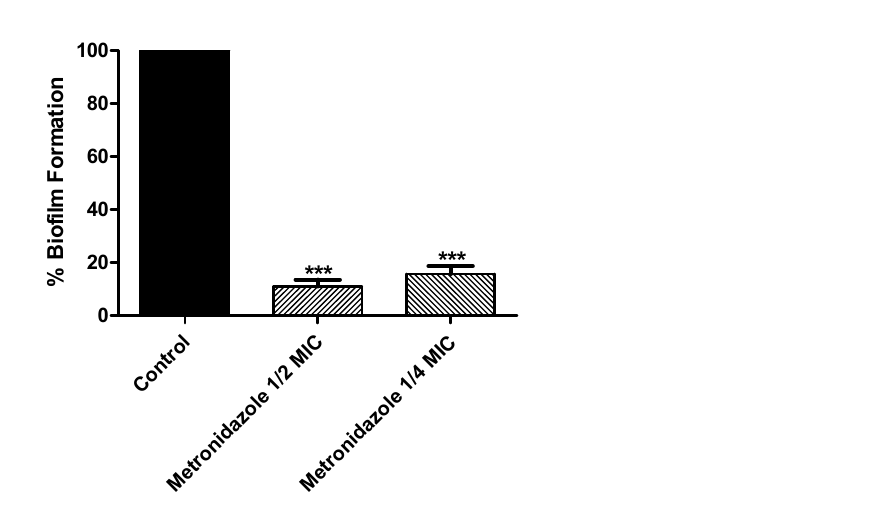
Figure 5. Effect of metronidazole in sub-MIC on biofilm formation. P. mirabilis cultures were grown in presence or absence of metronidazole (½ MIC or ¼ MIC) and incubated overnight at 37 °C. The optical densities of stained adhered cells were measured at 590 nm. Significantly, metronidazole diminished the biofilm formation ( p < 0.0001). One-way ANOVA test was used to compare between the metronidazole in ½ MIC or ¼ MIC treated and untreated bacterial cultures. The data were presented as mean ± standard error of percentage change from untreated cultures; and and statistical significance was considered when p values < 0.05, *** = p < 0.001.